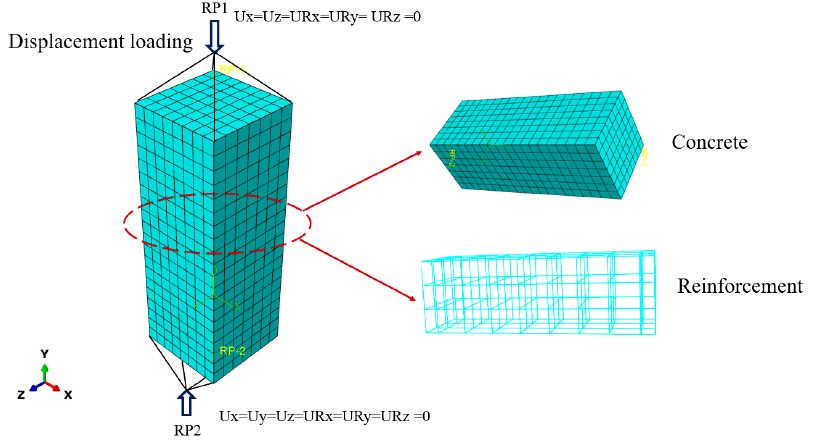
Figure 3. Finite element analysis model.